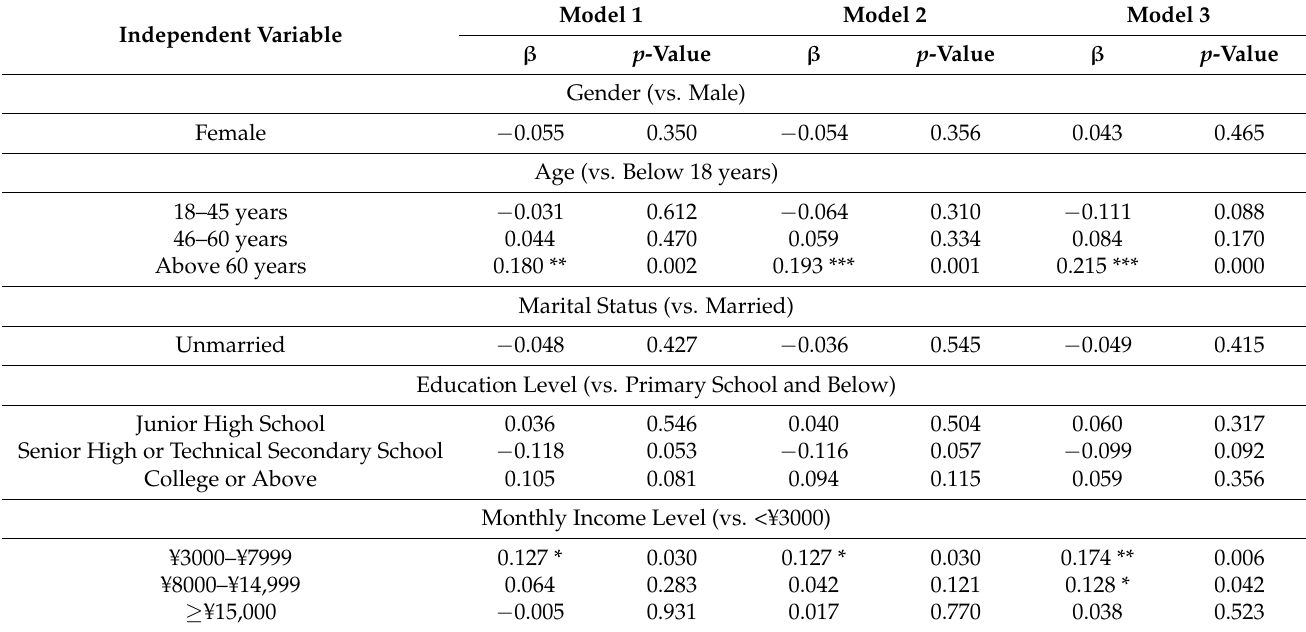
Table 4. Results of stepwise linear regression of the level of residents’